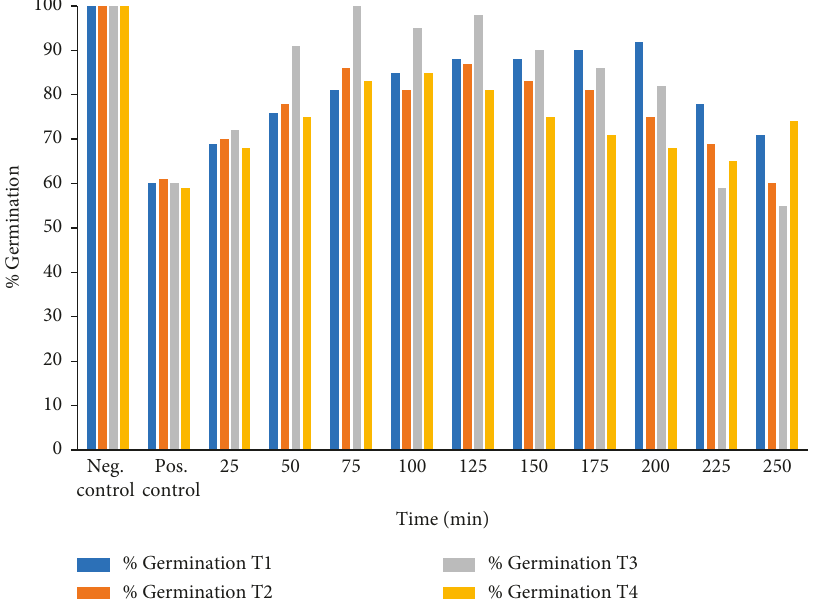
Figure 6: Percentage of germination of diethyl (3H-1-ethoxy-3-phenoxazinylidene) ammonium chloride as a function of the plasma exposure time and